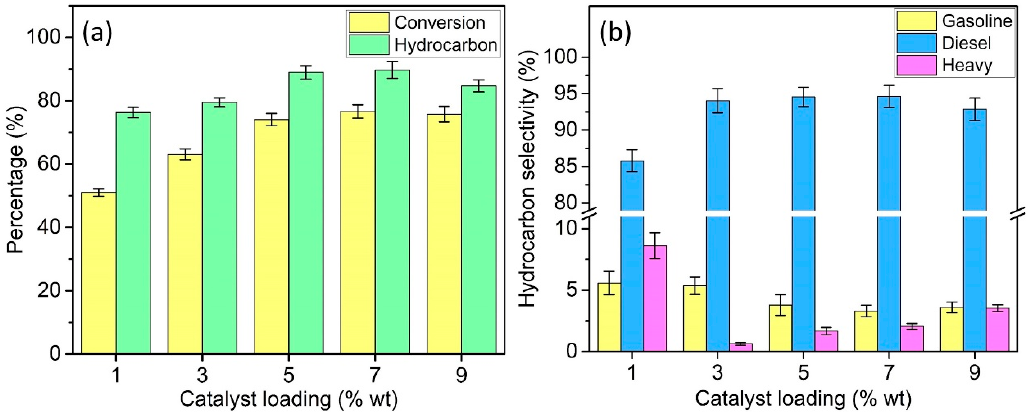
Figure 6. Effect of catalyst loading on ( a ) conversion and hydrocarbon product and ( b ) hydrocarbon selectivity from deoxygenation of triolein over DP-Y65.